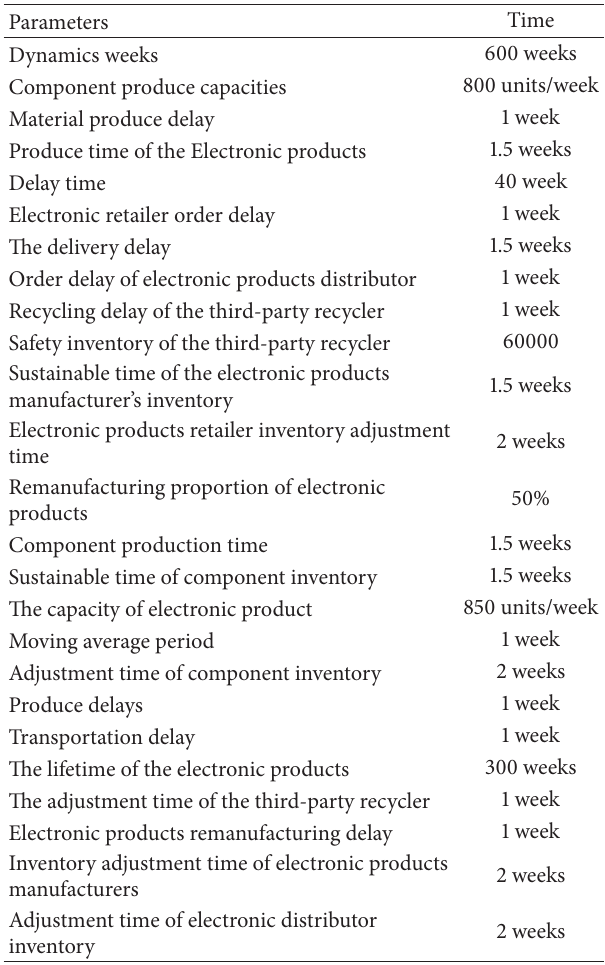
Table 1: The constant